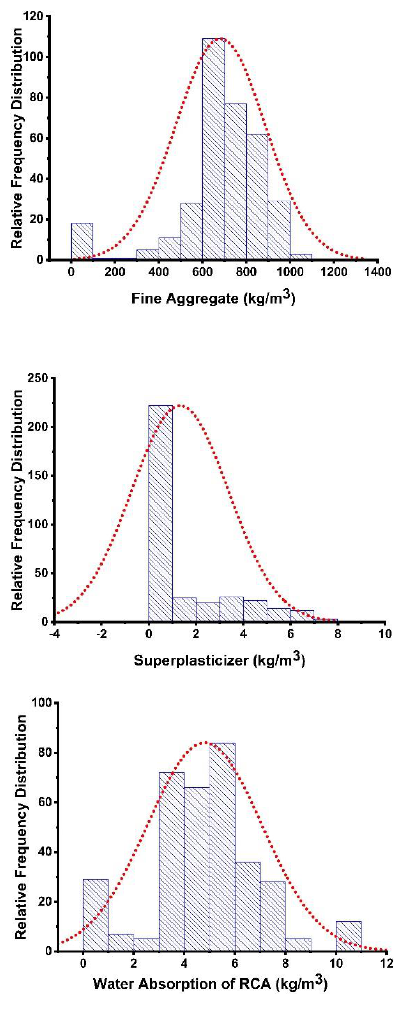
Figure 1. Histograms of the input parameters showing the relative frequency scattering.